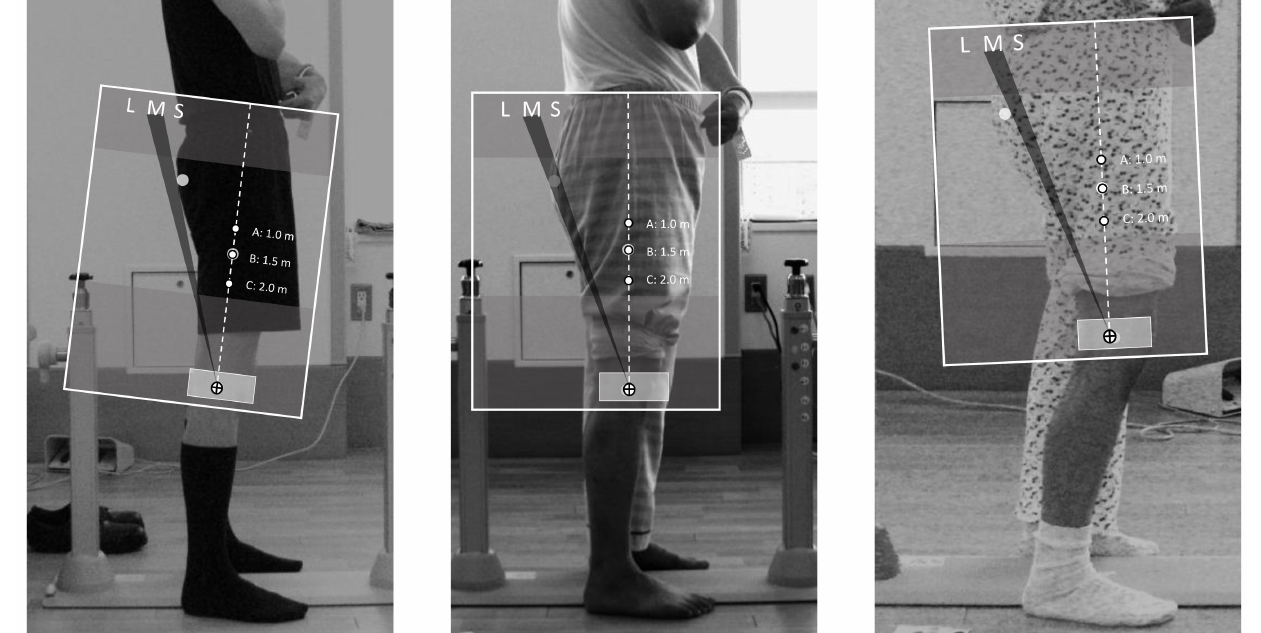
Figure 4. Application examples of the practical PI classification tool. Left photo shows in case of HKL angle classified “S”, meaning small (<42 ◦ ) PI. Similarly, the center photo shows in case of the HKL angle classified “M”, meaning medium (42–51 ◦ ) PI. The right photo shows in case of the HKL angle classified “L”, meaning large (>51 ◦ )